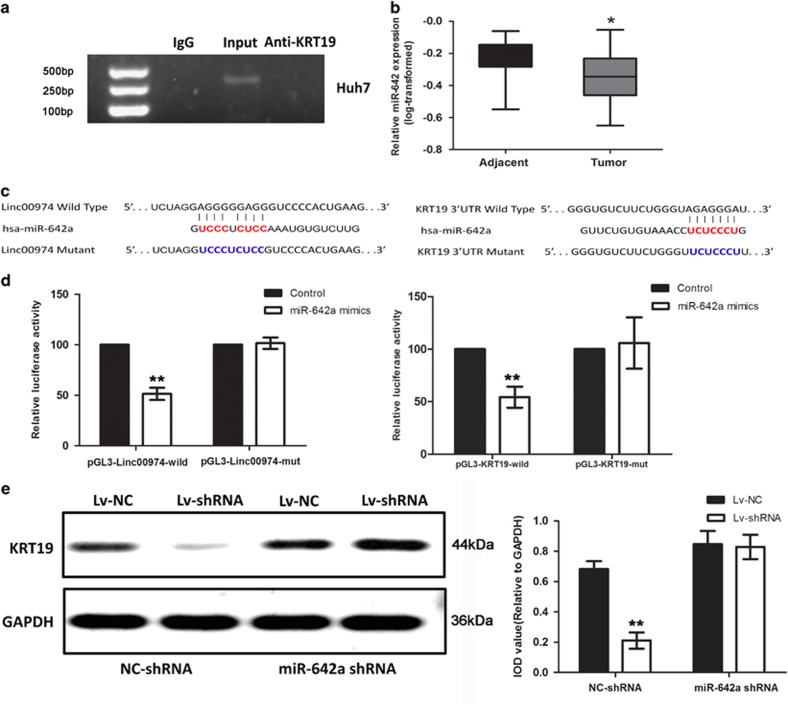
Linc00974 could regulate KRT19 via ceRNA interacting mechanism with the invasion of miR-642. (a) Relative RIP experiments were performed using an antibody against KRT19 on extracts from Huh7 with IgG as a negative control. The enrichment of the Linc00974 was normalized to the input. The purified RNA was used for RT-PCR analysis. The results showed that no bands were detected from the RNA in the group with anti-KRT19. (b) Relative expression level of miR-642 in clinical samples. Data was log-transformed as presented with mean±S.D. (c) Bioinformatics predicted the binding site between the miR-642 with Linc00974 and KRT19, and the mutation types were conducted into the pGL3 plasmid as presented. (d) Cells were co-transfected with miR-642a mimics or control, Renilla luciferase vector pRL-SV40 and Linc00974 full length or KRT19 3′UTR luciferase reporters for 48 h. Both firefly and Renilla luciferase activities were measured in the same sample. Firefly luciferase signals were normalized with Renilla luciferase signals. Cells treated with controls of miRNA were normalized to 100%. (e) KRT19 protein expression level was detected by western blotting. Cells were treated with Linc00974 shRNA or miR-642a shRNA and the respective control plasmid. IOD was calculated for each band. All tests were performed in triplicate and presented as the mean±S.E.M. *P<0.05, **P<0.01